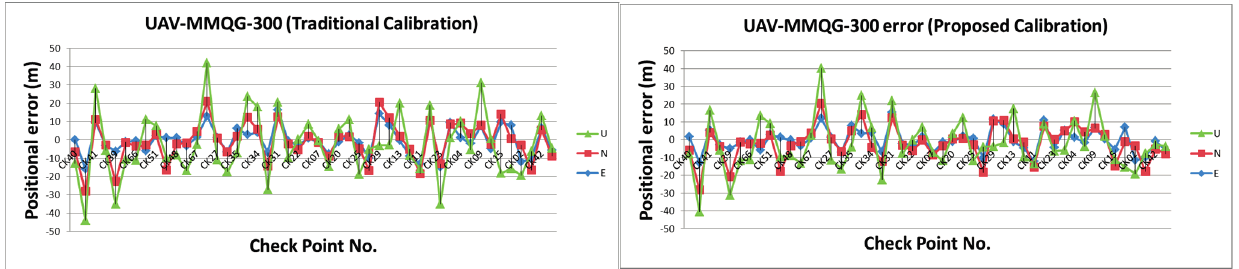
Figure 24. DG error based on MMQG with 600 m.